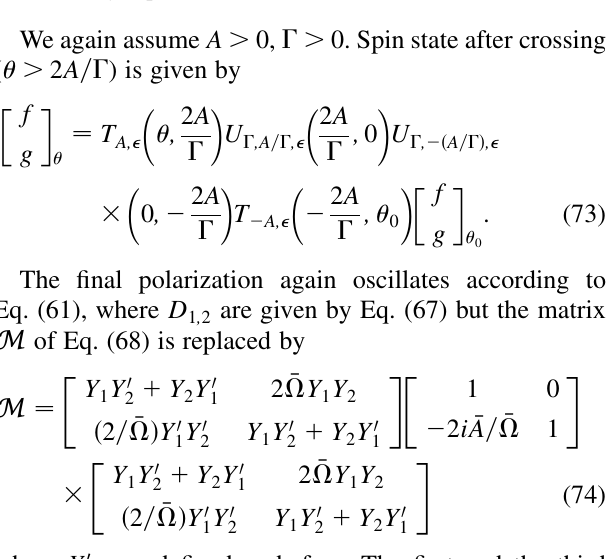
FIG. 10. Crossing the resonance 3 times, two sloped-steps and one sudden